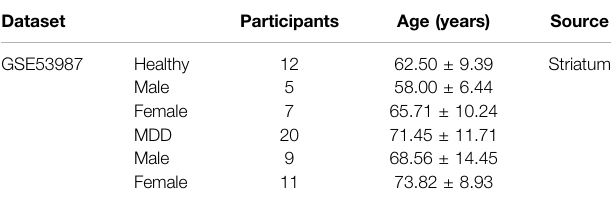
TABLE 4 | Clinical and demographic characteristics of participants (GSE53987) included in the present